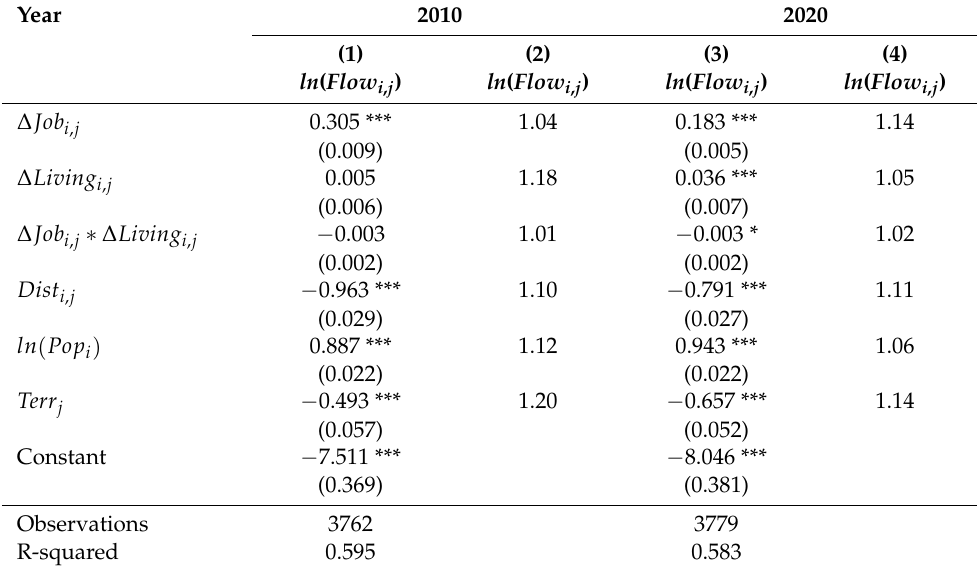
Table 3. The regression results of model (2).